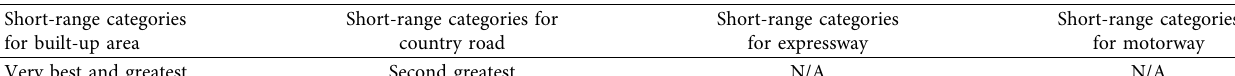
Table 7: Short-range categories assigned to road types based on the aggregated scores in Table 6. The score difference required for the “very best” category—in this scale—was 40, while for the “worst-by-far” category—also in this scale—it was 20.